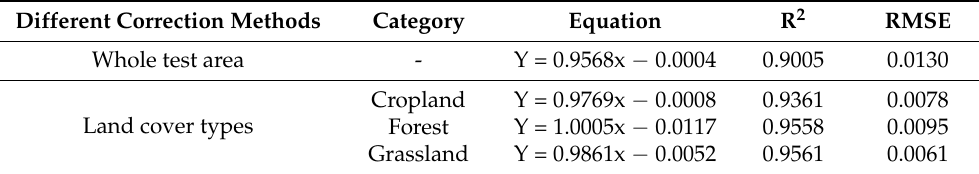
test area based on images from the same sensor.